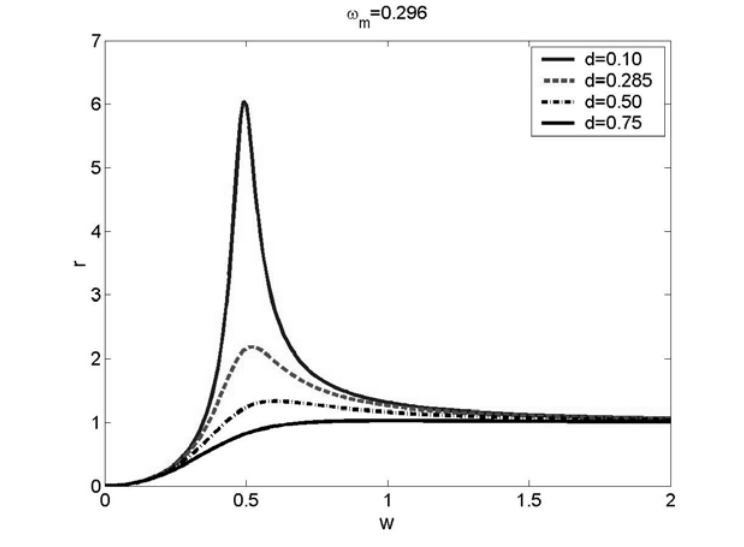
Fig. 10. Relative engine mass displacement.